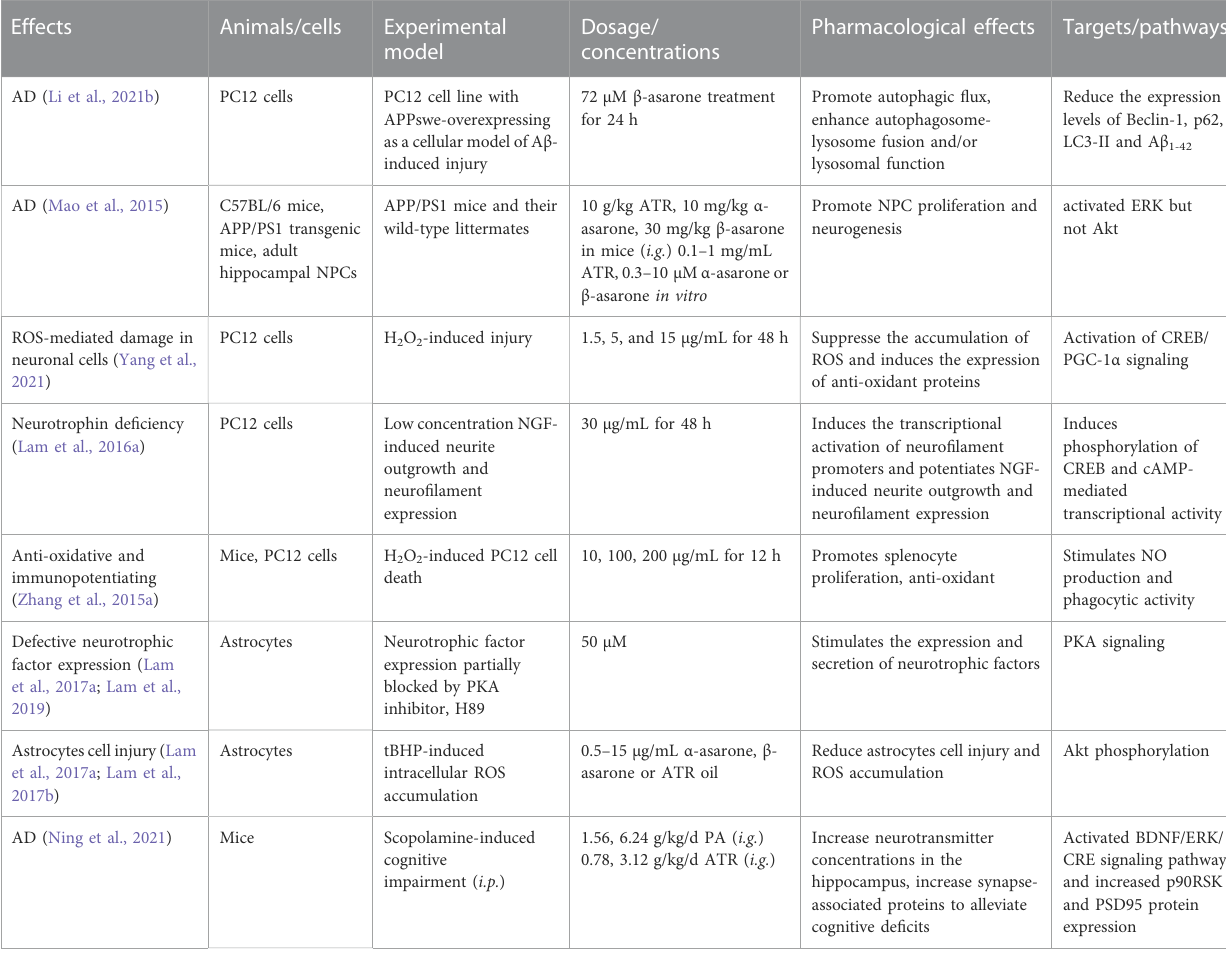
TABLE 5 Effects of ATR on the central nervous